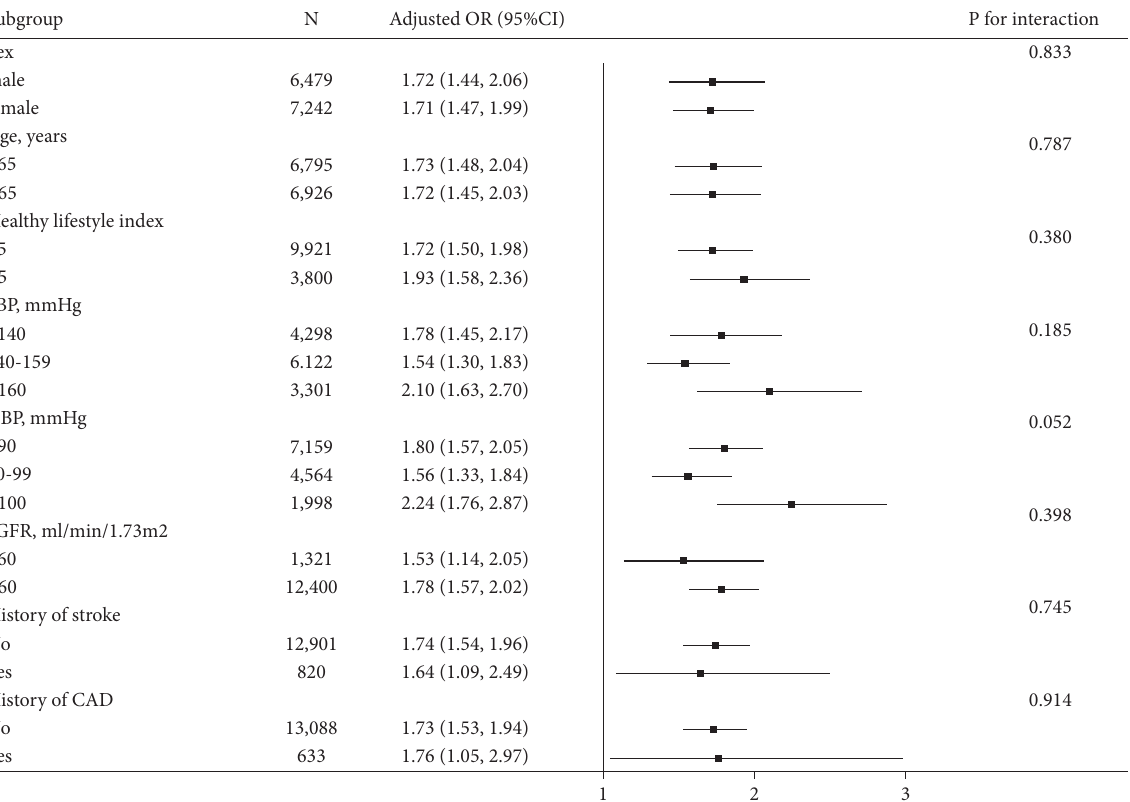
Figure 3: Subgroup analyses of the OR (95% CI) of TRL-C on the prevalence of DM. Adjusted for age, sex, BMI, current smoking, current drinking, SBP, DBP, eGFR, history of stroke and CAD, and antihypertensive drugs, if not be